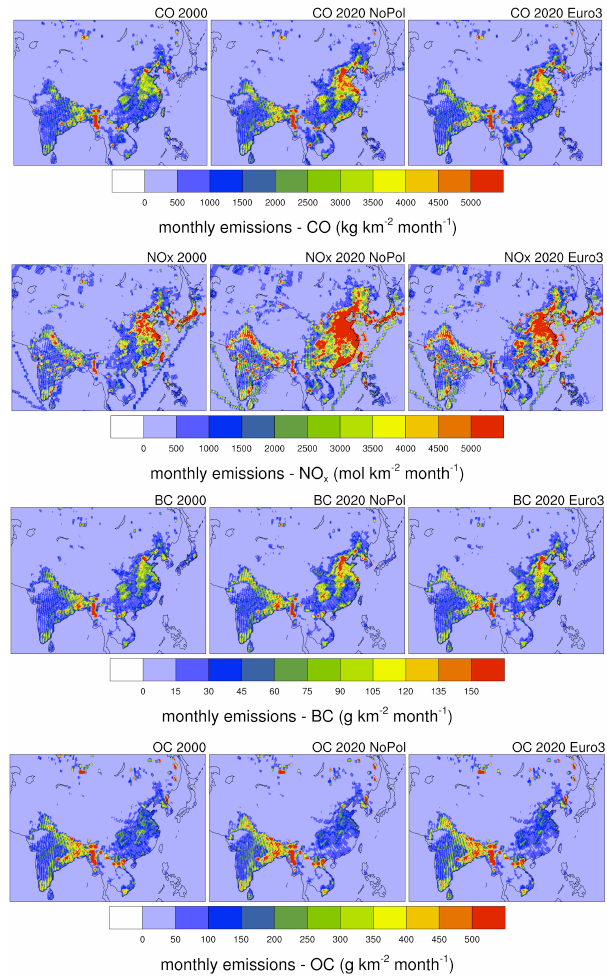
Fig. 3. The monthly mean surface emissions of CO [kg km -2 month -1 ] (top), NO x [mol km -1 month -1 ] (second top), BC [g km -2 month -1 ] (second bottom) and OC [g km -2 month -1 ] (bottom) in April, used in WRF/Chem for 2000 baseline, 2020 NoPol and 2020 Euro 3 scenarios.